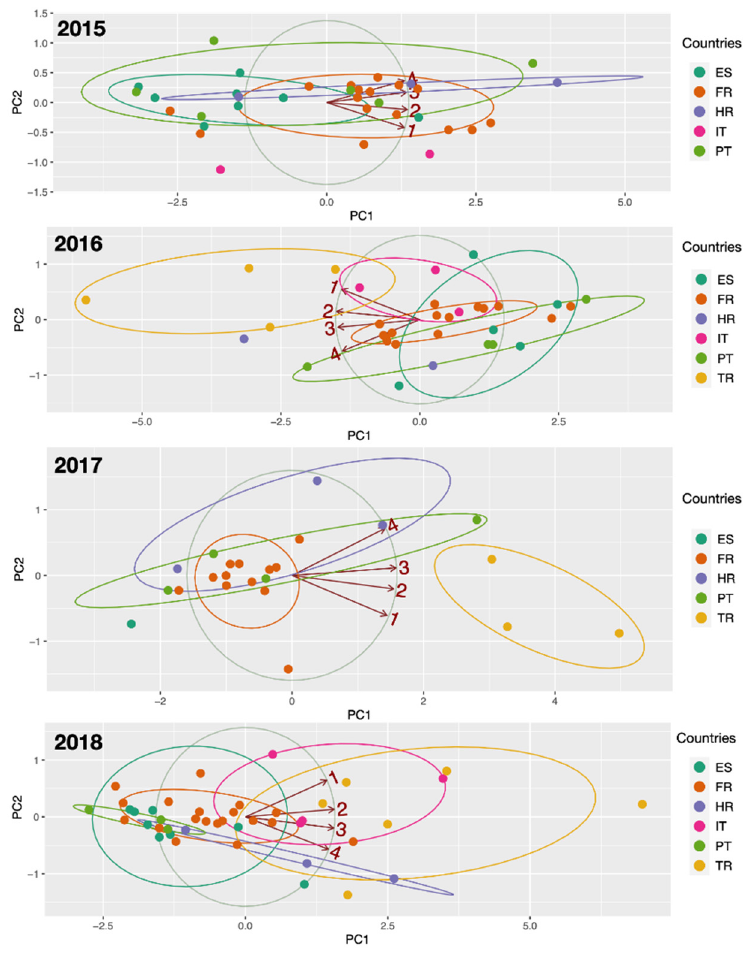
Figure 9. PCA biplot analysis for PM 2.5 (2015–2018), showing the relative position of monitoring stations by countries concerning the principal components. BA—Bosnia and Herzegovina; ES—Spain;